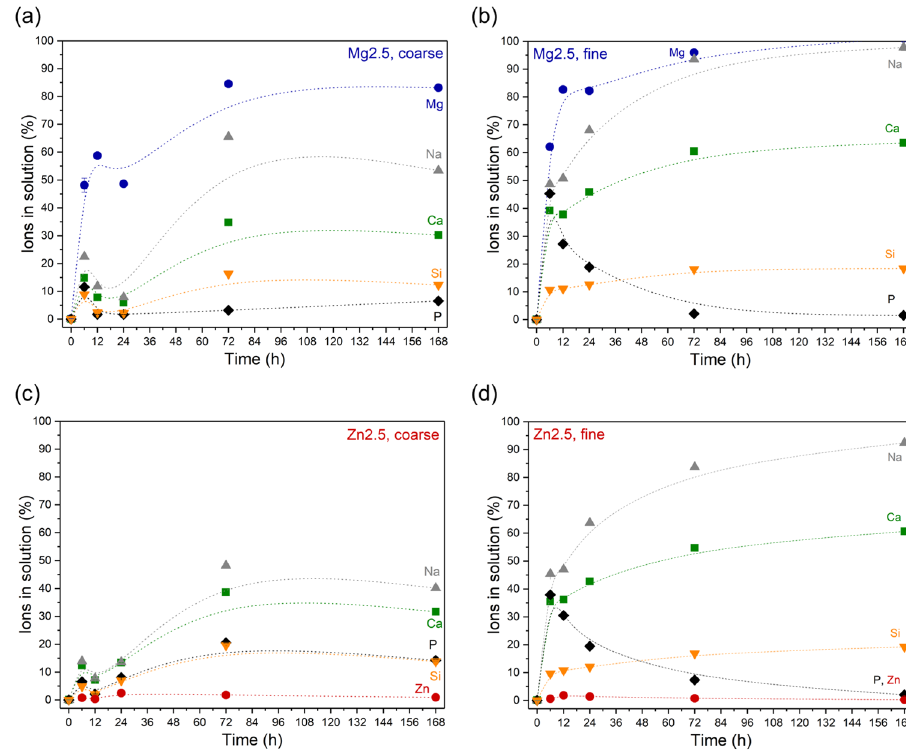
Fig. 1. If the glass components are packed closer to one another, it becomes more dif fi cult for water molecules to penetrate the network [22] and allow for ion exchange to occur.